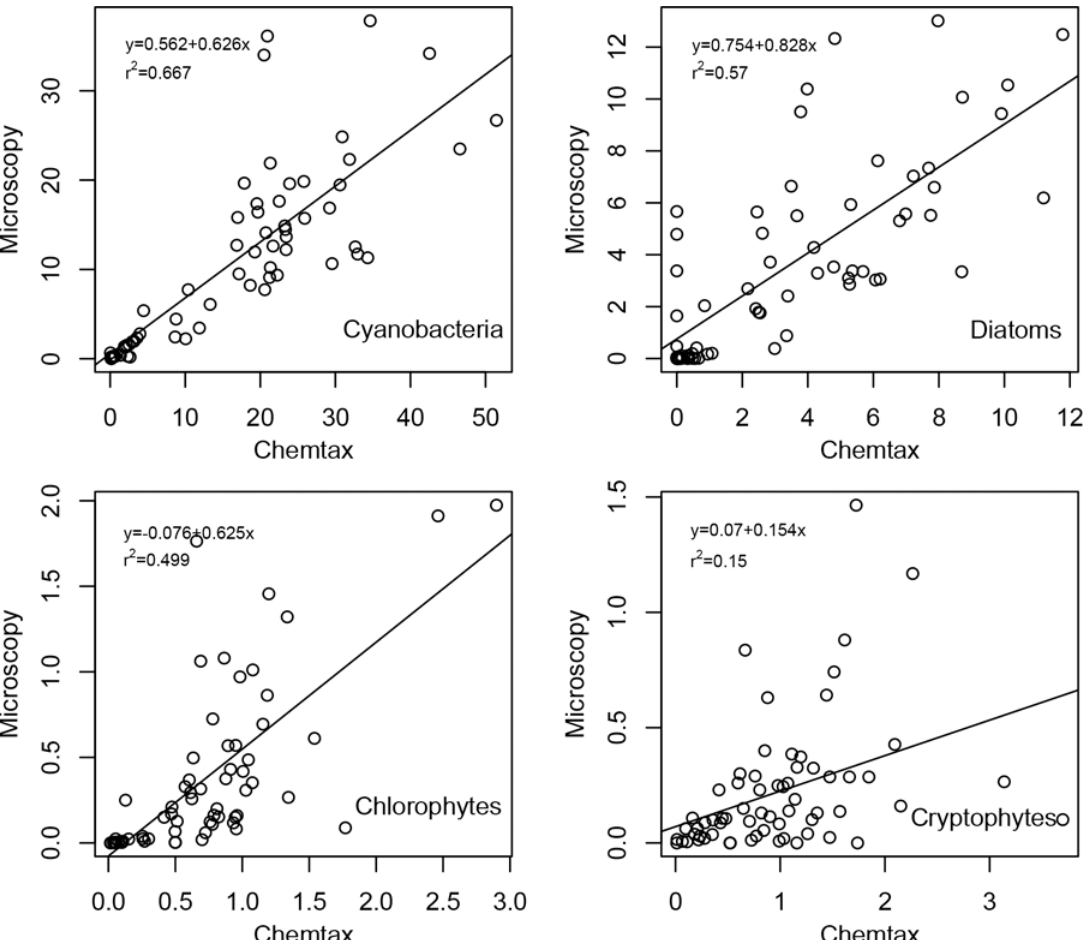
Fig 7. Linear regression of CHEMTAX and microscopy results for cyanobacteria, diatoms, chlorophytes and cryptophytes in Lake V õ rtsjärv (2009 – 2013).